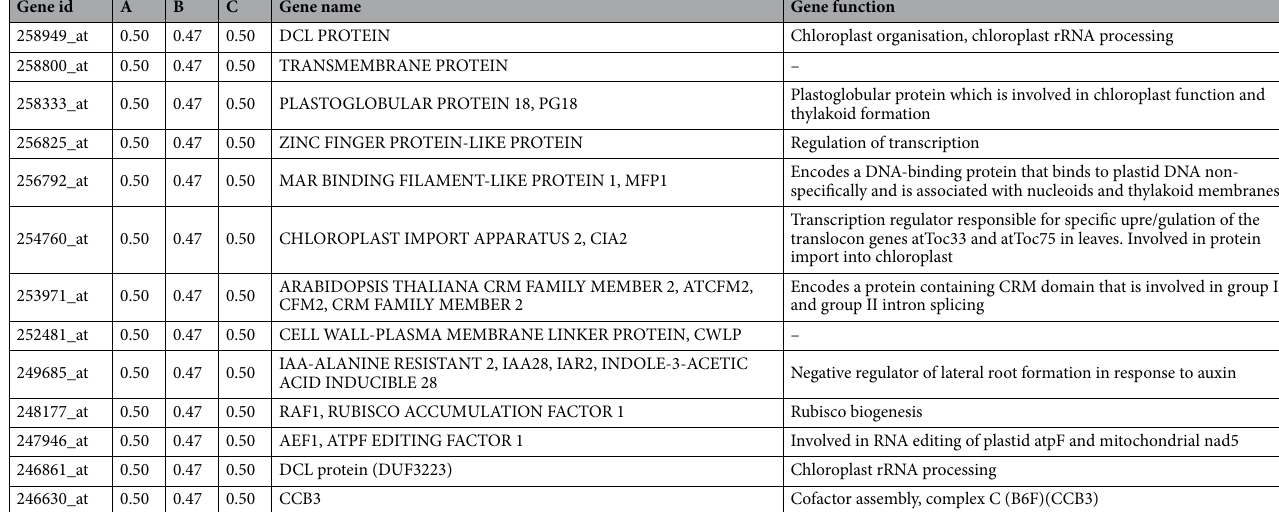
Table 1. Common PP2A gene ids across all subunits with high centrality scores along with their gene name and